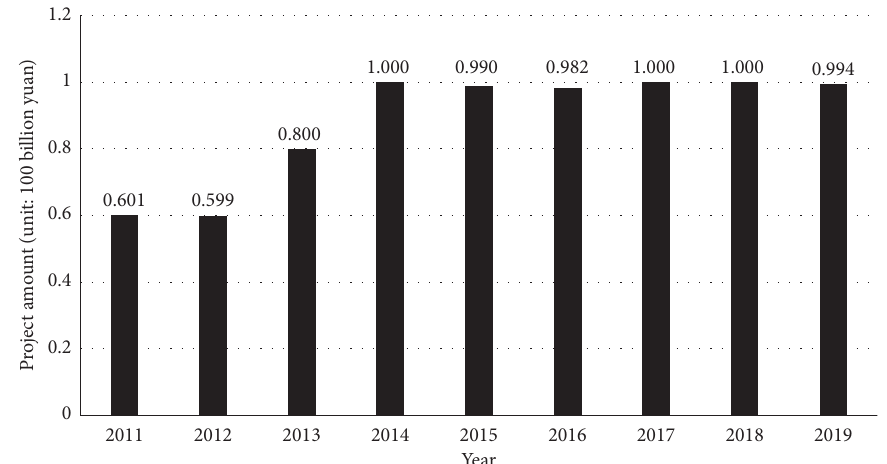
Figure 2: Amount of special funds support projects for sports industry development in Jiangsu province from 2011 to